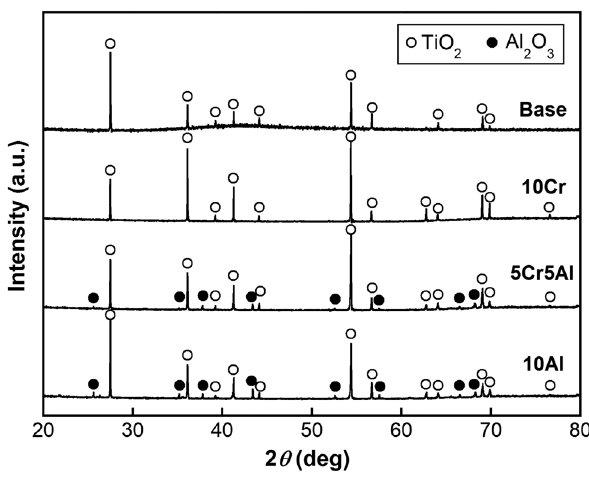
Figure 8: XRD spectra of the specimen surface of the base, 10Cr, 5Cr5Al and 10Al alloys oxidized at 1,100°C for 12 h.